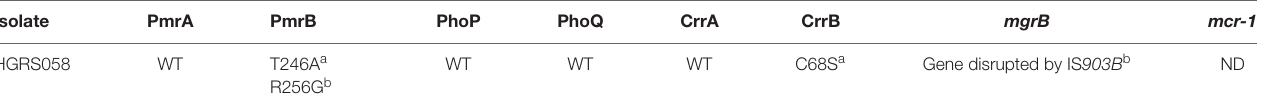
TABLE 3 | Mutation analysis of genes involved in colistin resistance of one ColR-CRKP sequenced isolate. Isolate PmrA